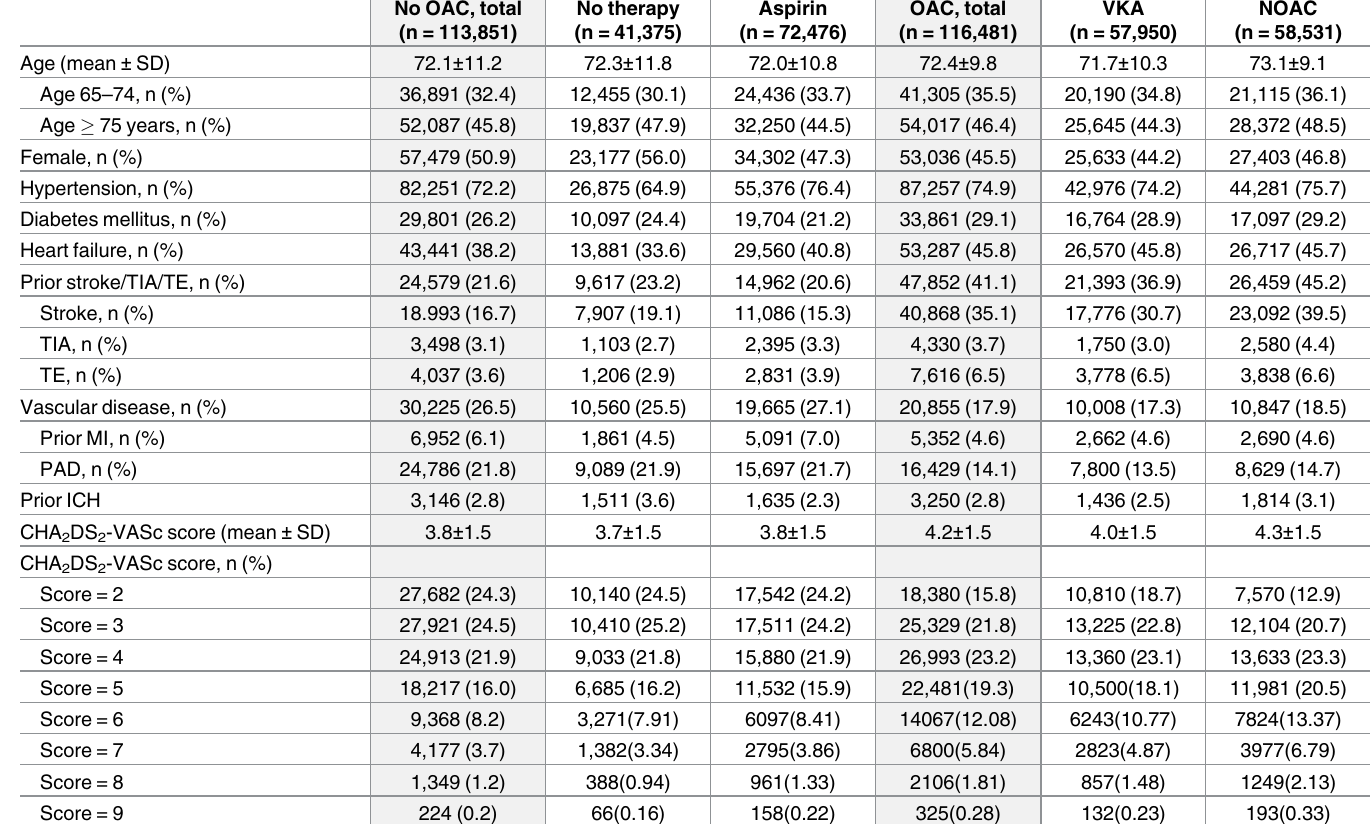
Table 1. Baseline characteristics of patients with CHA 2 DS 2 -VASc score (cid:21) 2 in 2015 (n = 230,332). No OAC, total (n =